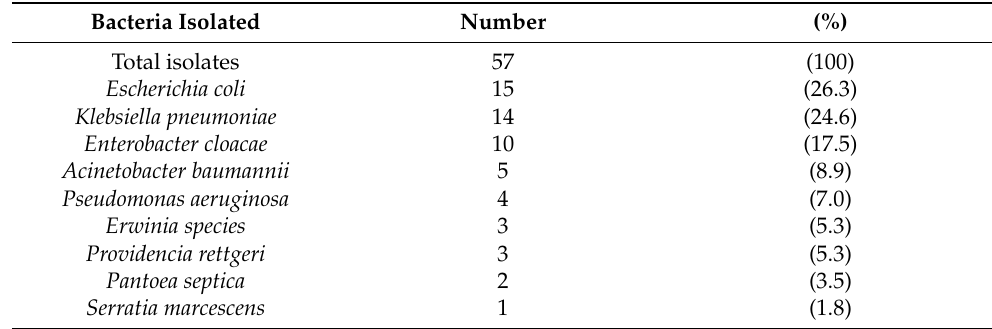
Table 2. Aerobic Gram-negative bacteria isolated from the nasopharynx of healthy under-five children in Accra, Ghana, from September to December 2016.